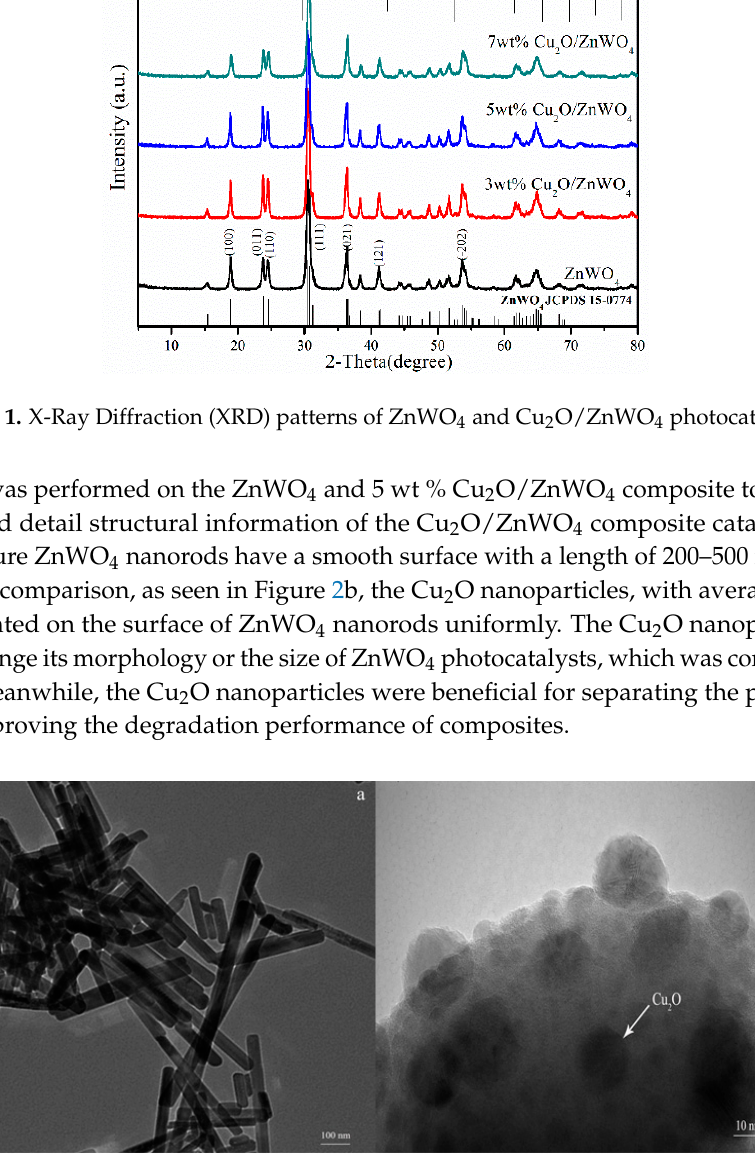
Figure 2. Transmission Electron Microscopy (TEM) images of ( a ) ZnWO 4 ; ( b ) Cu 2 O/ZnWO 4 .